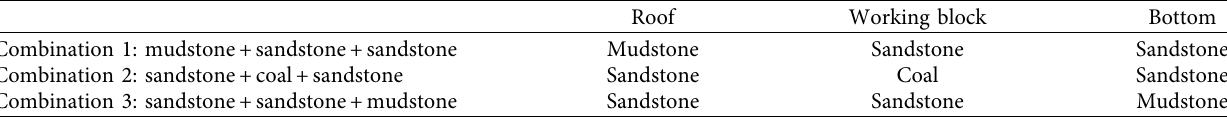
Table 3: Combination modes of block lithology.